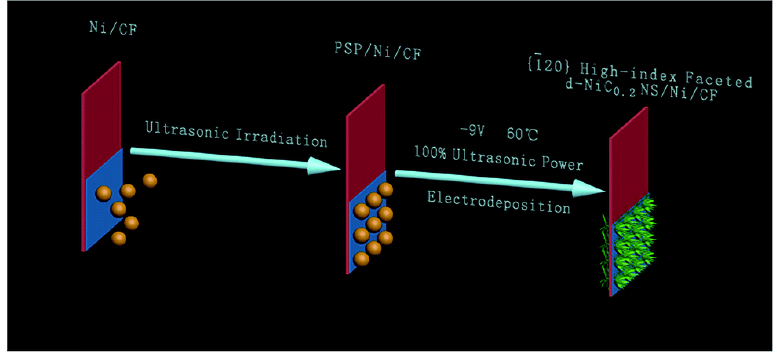
Figure 1. Schematic illustration of the synthetic route for d-NiC 0.2 NS / Ni / CF. By using nickel sulfate and polystyrylpyridine resins (PSP) as the nickel and carbon precursor, the samples were obtained via a controllable and mild electrodeposition process with ultrasonic treatment at 60 ◦ C Reproduced with permission from [48]. Copyright 2016 Journal of Materials Chemistry A .